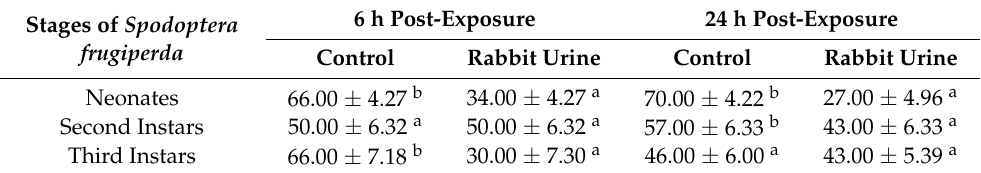
Table 2. Mean number ( ± SE) of fall armyworm larvae that oriented and settled on the maize leaves treated with rabbit urine and distilled water (control) within 6 and 24 h of exposure in the two-choice experiment.